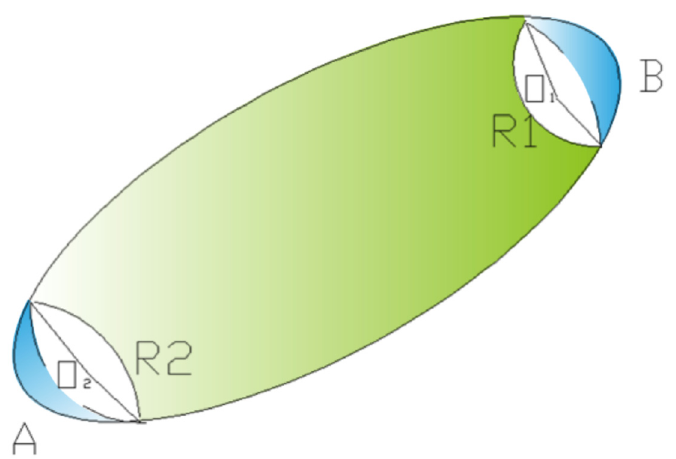
Figure 10. Center point method to identify whether short fibers in different slice sections are the same fiber.